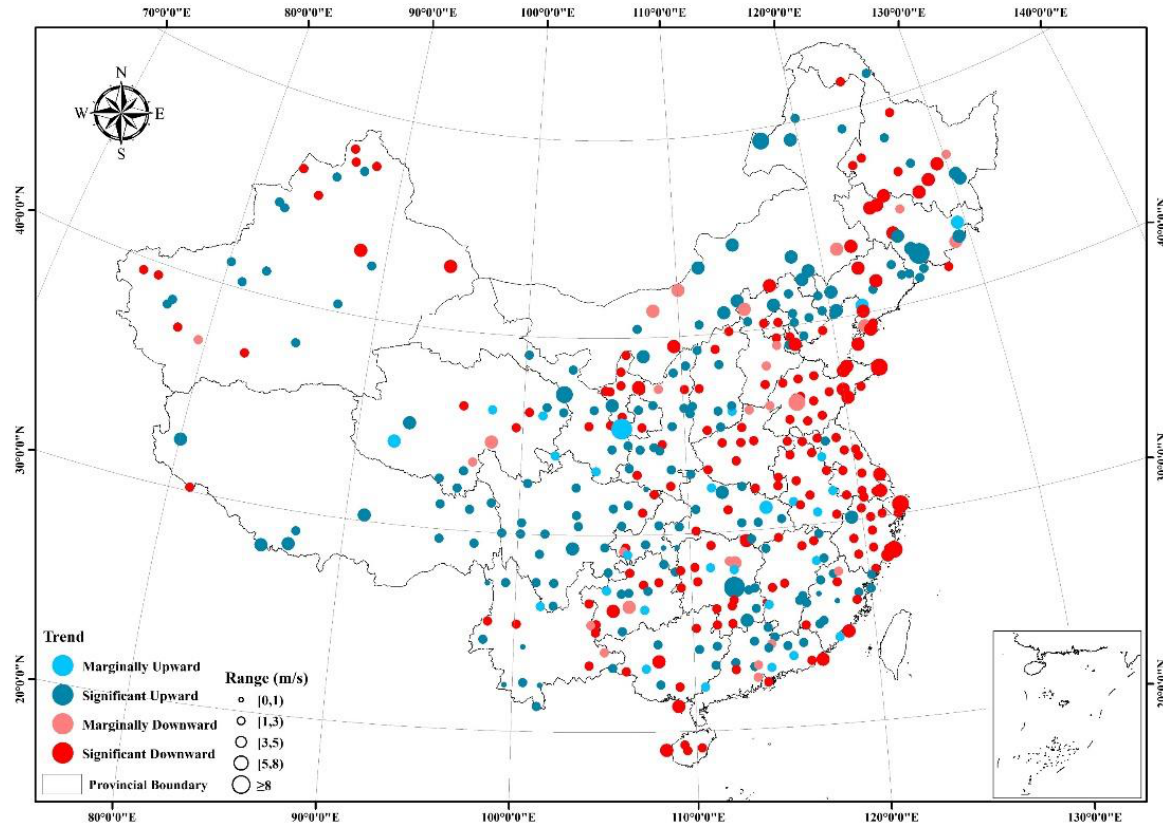
Figure 5. Wind speed range and trend distribution map of 697 meteorological stations in China from 2000 to 2019.